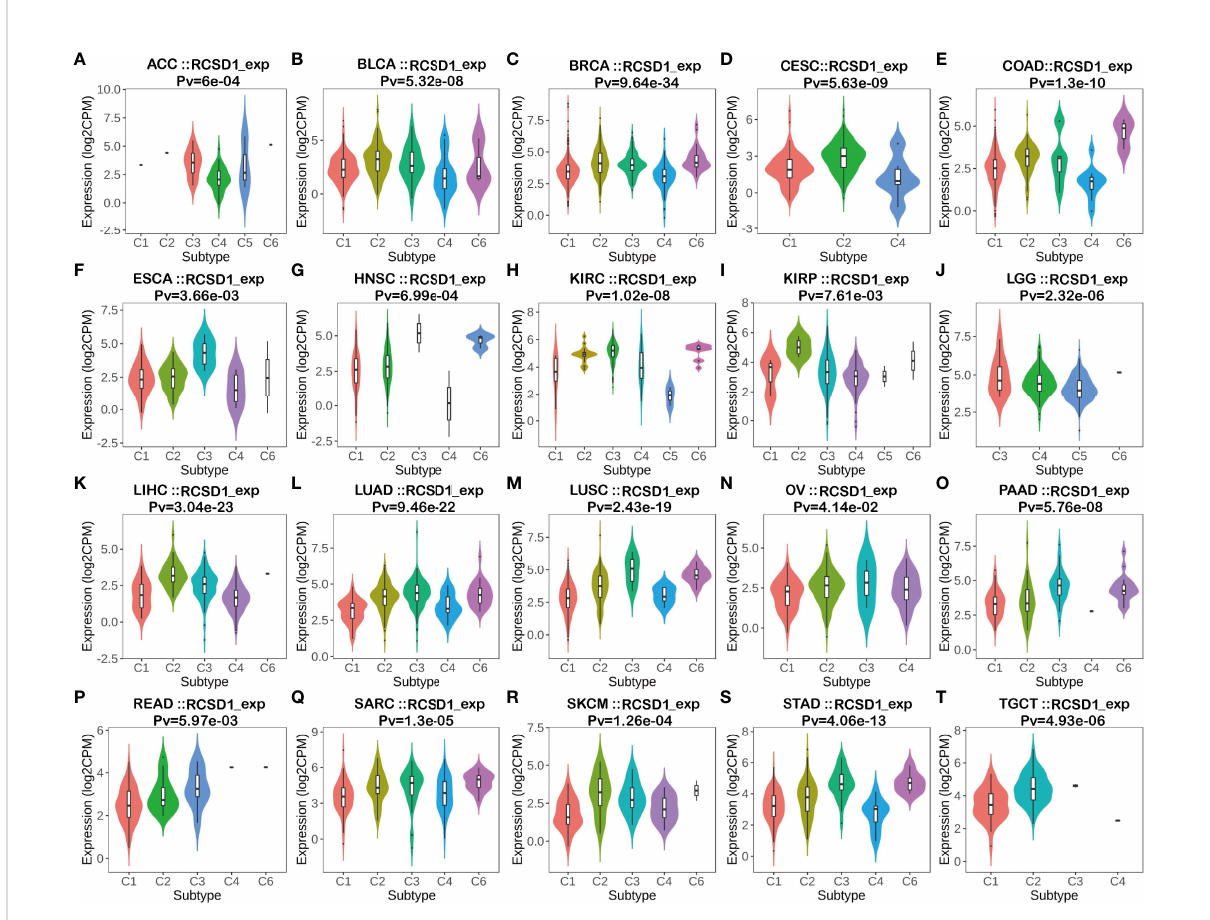
FIGURE 6 The relationship between RCSD1 expression and pan-cancer immune subtypes. (A) in ACC, (B) in BLCA, (C) in BRCA, (D) in CESC, (E) in COAD, (F) in ESCA, (G) in HNSC, (H) in KIRC, (I) in KIRP, (J) in LGG, (K) in LIHC, (L) in LUAD, (M) in LUSC, (N) in OV, (O) in PAAD, (P) in READ, (Q) in SARC, (R) in SKCM, (S) in STAD, (T) in